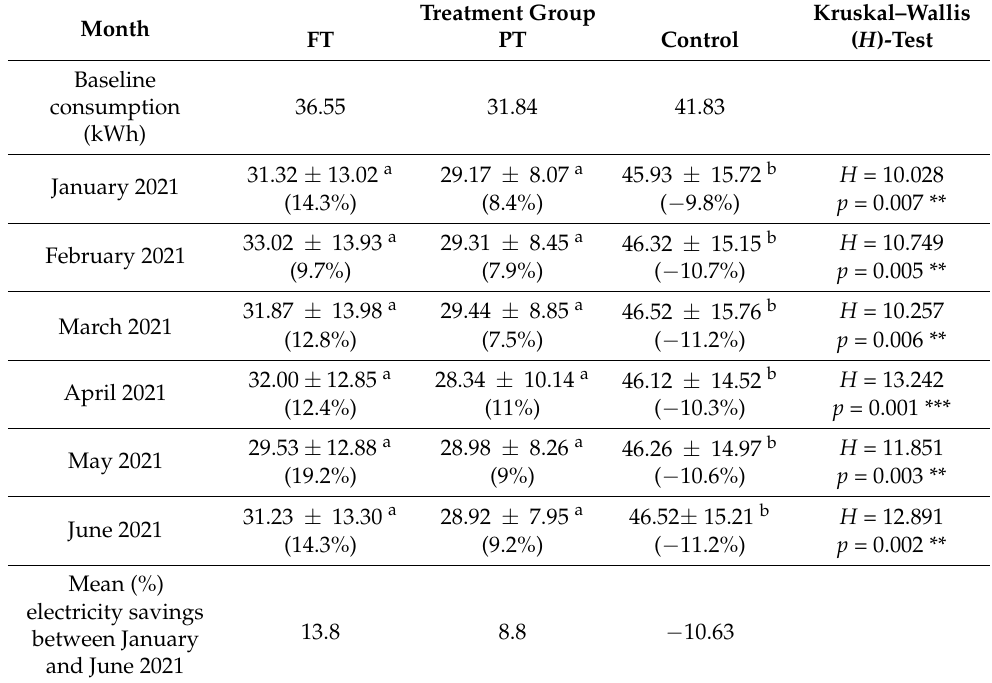
Table 3. Post-intervention monthly mean electricity consumption. Electricity savings (reductions) and increases in consumption are represented by positive and negative values (%) in bracket. Letters a, b represent significant differences between treatment groups.